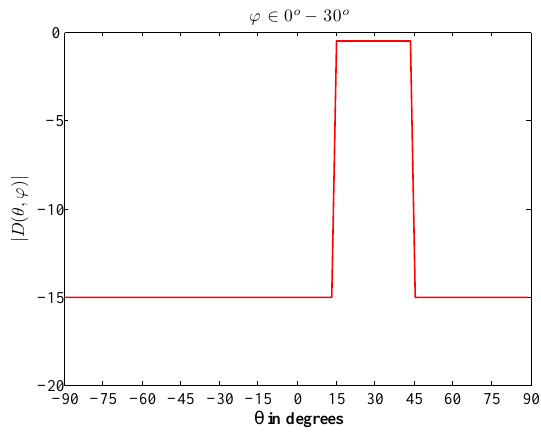
Figure 2: Desired scanned Flat-top beam pattern